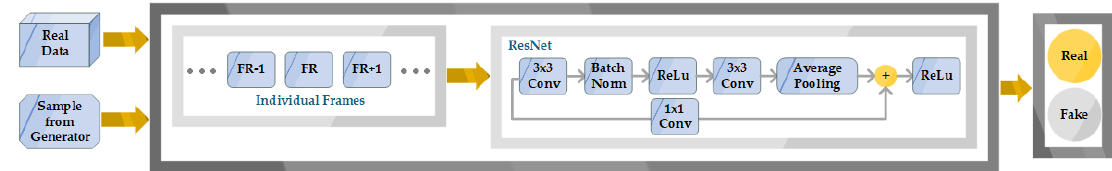
Figure 4. Architecture of the spatial